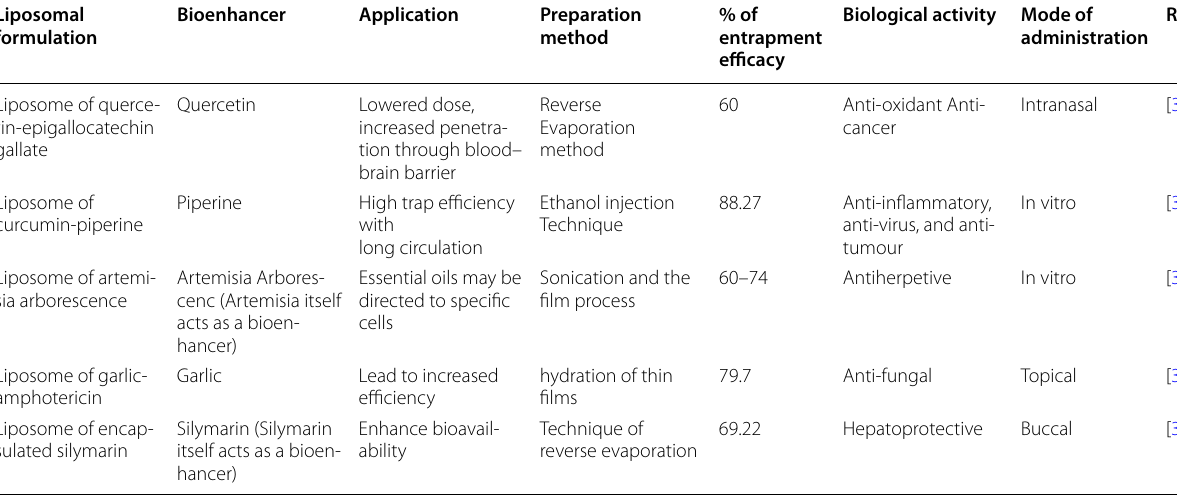
Table 2 Liposomal formulation containing natural bioenhancer Liposomal Bioenhancer Application Preparation formulation